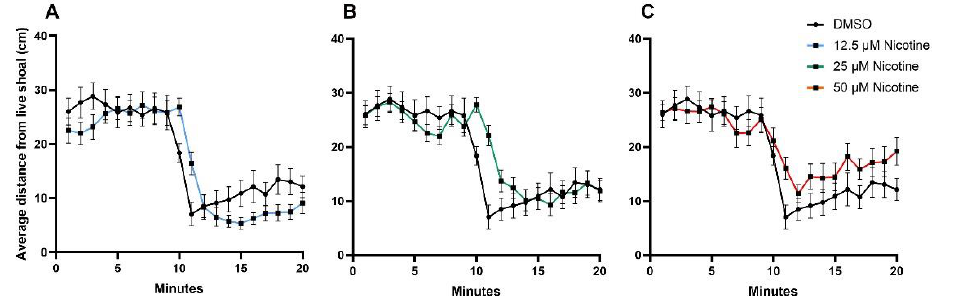
Figure 5. Embryonic nicotine exposure reduces the shoaling response in adult zebrafish. Average distance between the experimental fish and the live shoal, plotted by minute of the 20-min behavioral session. Mean ± SEM is shown. A t-test was used to calculate significance between two groups. ( A ) Comparison between DMSO (n = 22) and 12.5 µM Nicotine (n = 22) groups ( p = 0.2717). ( B ) Comparison between DMSO and 25 µM Nicotine (n = 30) groups ( p = 0.4708). ( C ) Comparison between DMSO and 50 µM nicotine (n = 23) groups ( p = 0.0499).